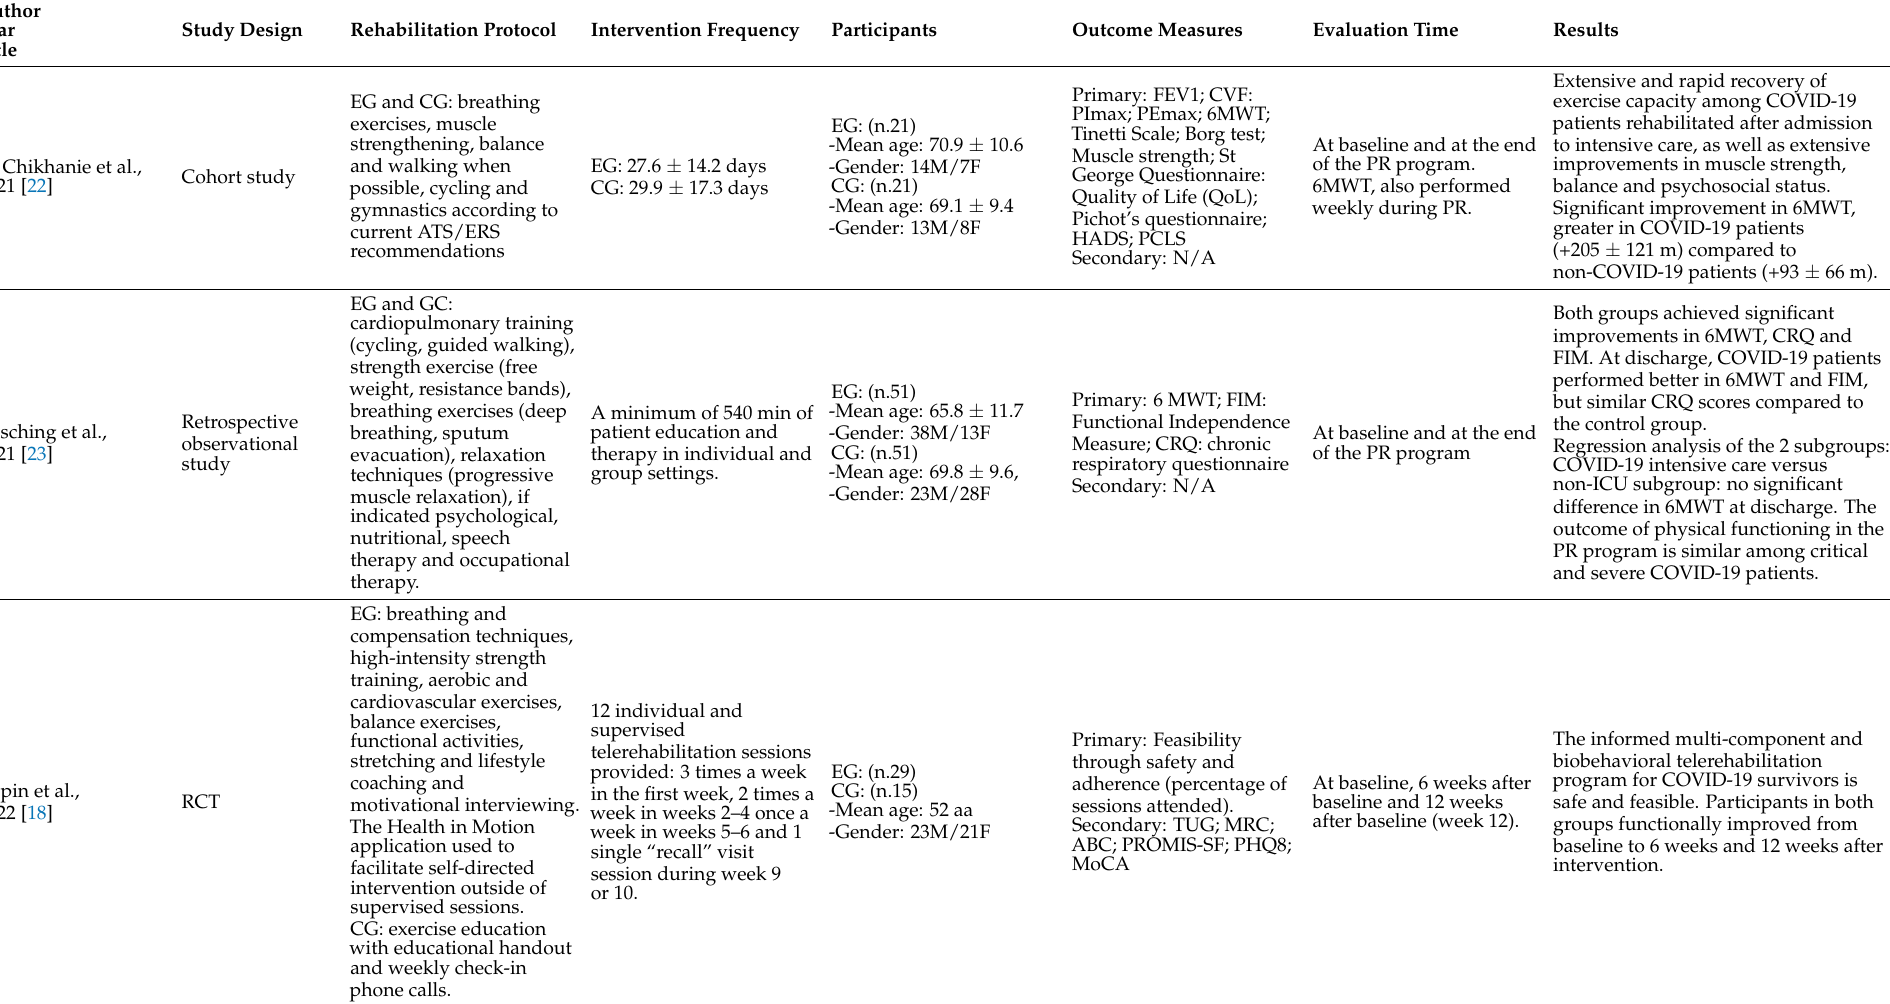
Table 5. Data Extraction of Selected